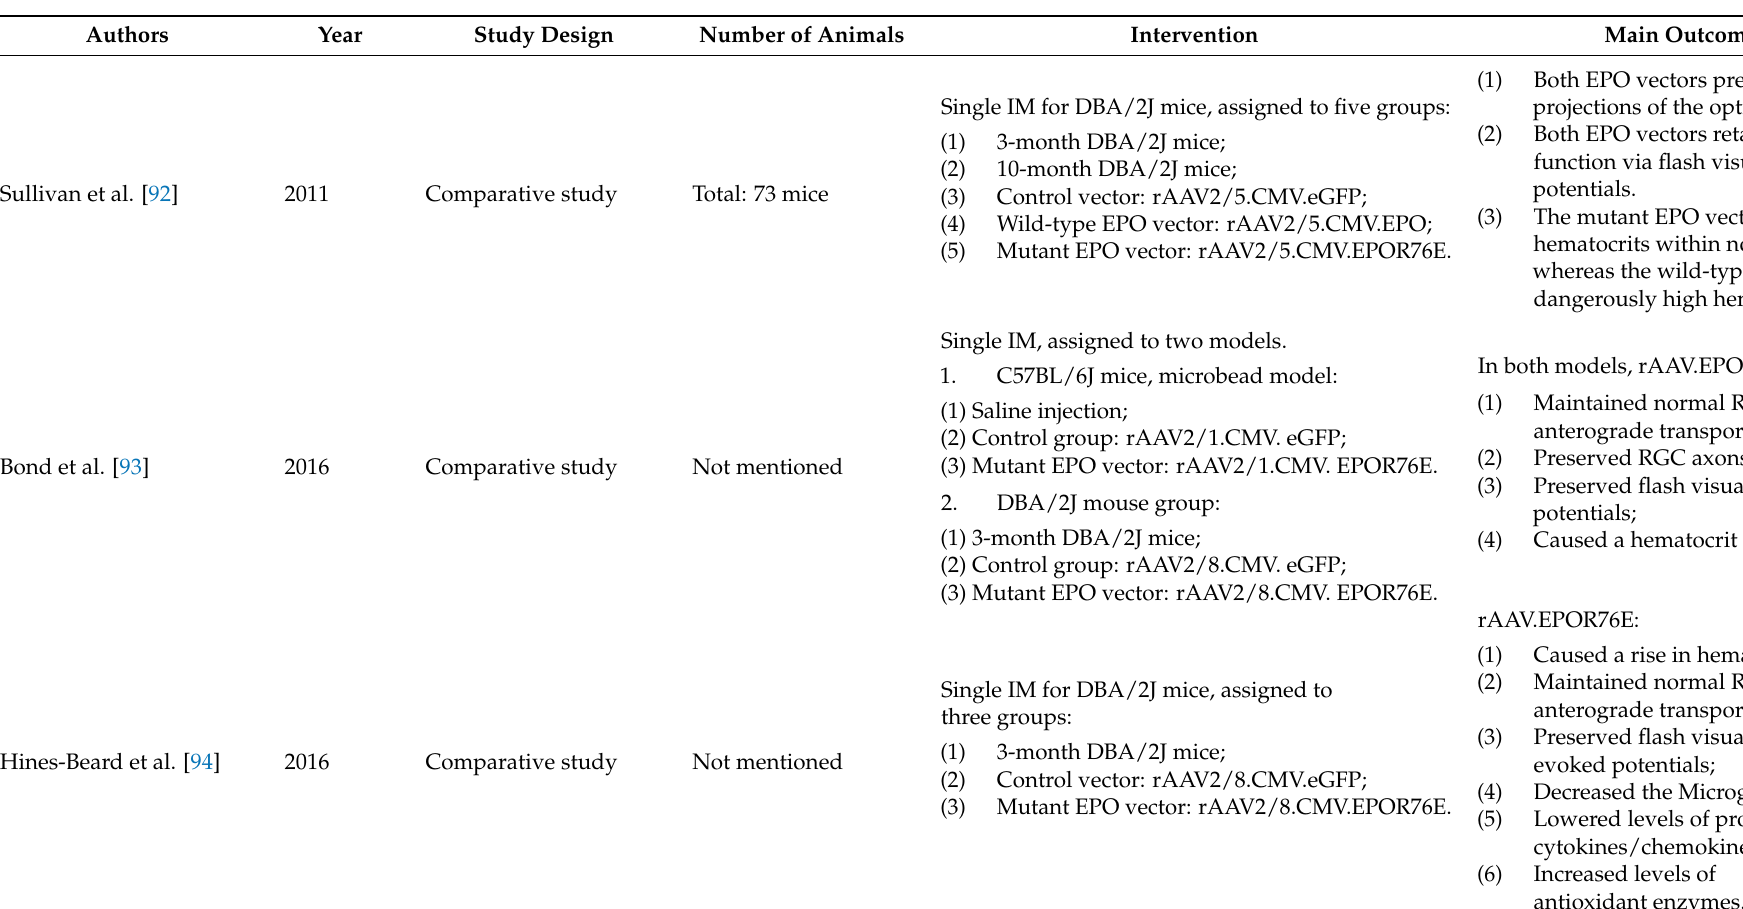
Table 2. Summary of studies that evaluated EPO gene therapy for